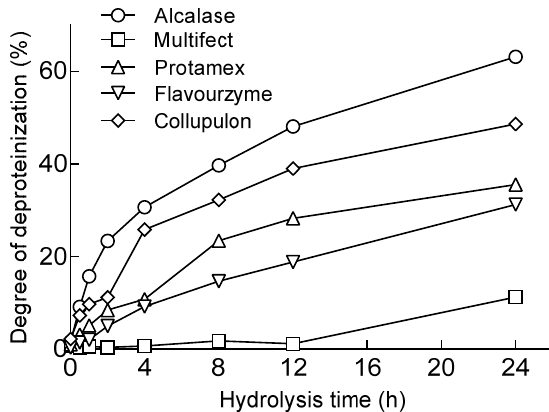
Figure 1. Changes in degree of deproteinization (DP) according to proteolytic enzymes during protein removal from mealworm larvae.